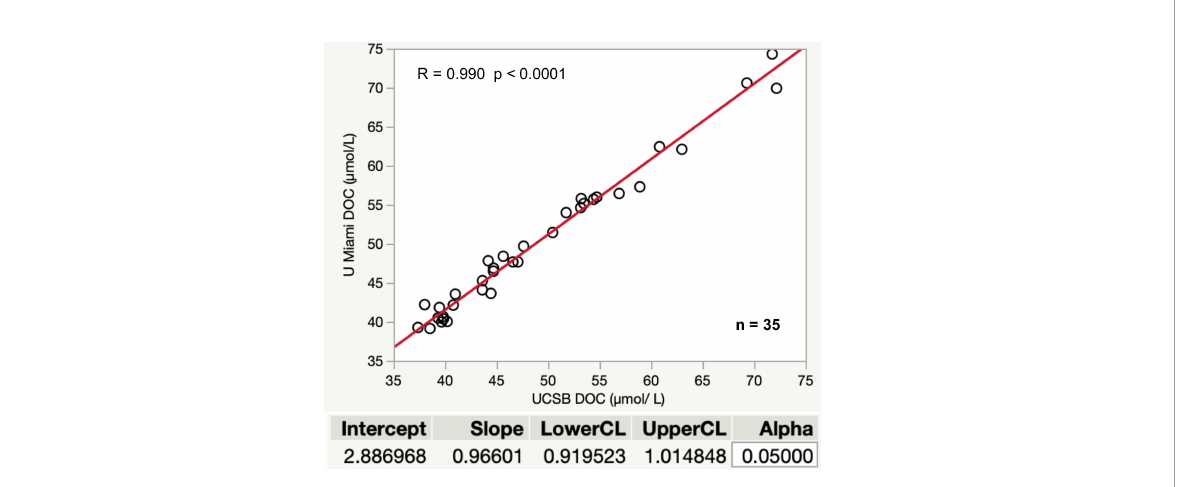
FIGURE 1 Results of interlaboratory comparisons conducted between UCSB and University of Miami between 2017- 2018. Samples include comparisons of CRMs, in-house references, and fi eld pro fi les collected from various locations in the Paci fi c and Atlantic Oceans. Samples were shared equally between the groups for analysis. Correlation coef fi cient shows a strong relationship between UCSB and UMIAMI data (R = 0.990, p< 0.001). Orthogonal regression (univariate variances, prin comp) using JMP software (JMP ® , Version<15>. SAS Institute Inc., Cary, NC, 1989 – 2021) gives a 0.919-1.015 con fi dence interval for the slope, which includes 1.0 and shows strong agreement between the values reported by each laboratory across a broad dynamic range, providing con fi dence in accurate and precise results for GO-SHIP data collected and analyzed as described in this best practices guide.